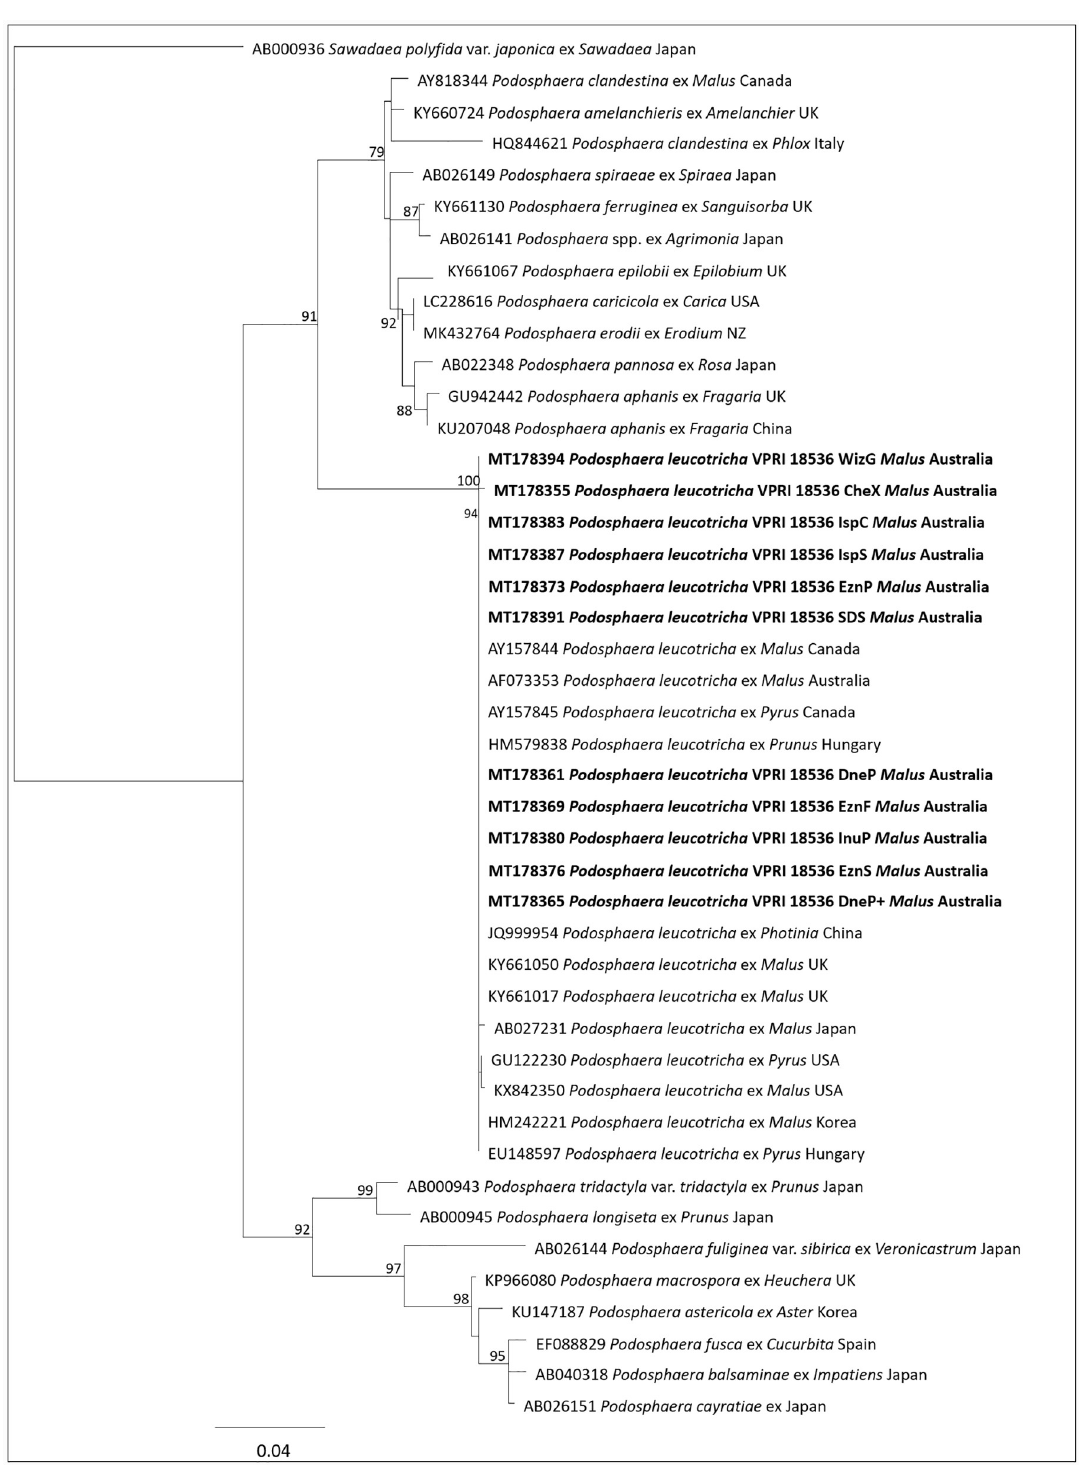
Fig 4. A Maximum Likelihood (ML) phylogenetic tree of the podosphaera leucotricha combined dataset of VPRI 18536 podosphaera leucotricha nested ITS PCR amplicons (bold) and other podosphaera species ITS sequence data taken from GenBank. This tree was generated using rDNA ITS1-5.8S-ITS2 sequences in PhyML with the GTR substitution model showing the relationship between VPRI P . leucotricha and GenBank P . leucotricha accession sequences. Bootstrap (BS) values of > 70% were taken from 1000 replications and are shown on the respective branches and the scale bar equals 5 changes per 100 bases.